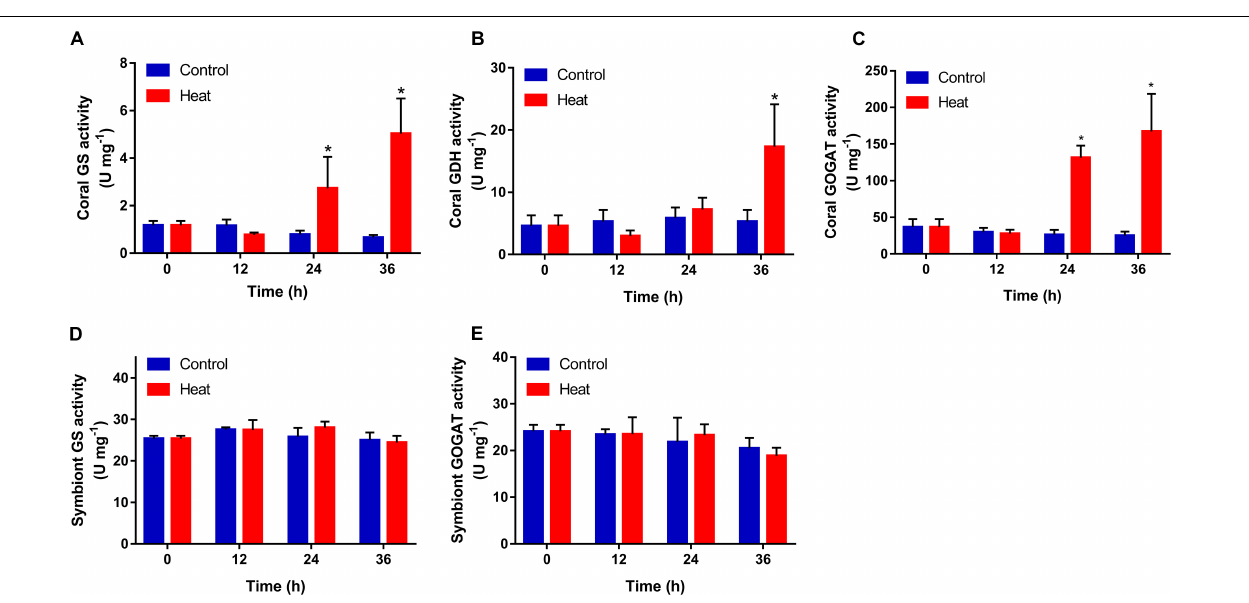
FIGURE 3 | Temporal activities of ammonium assimilation enzymes in the scleractinian coral Pocillopora damicornis and its symbionts after heat treatment. (A) Glutamine synthetase (GS) in the coral. (B) Glutamate dehydrogenase (GDH) in the coral. (C) Glutamine oxoglutarate aminotransferase (GOGAT) in the coral. (D) GS in the symbionts. (E) GOGAT in the symbionts. Data points represent means and error bars represent standard deviations ( N = 6). Asterisks depict significant differences between the heat and control groups ( p <